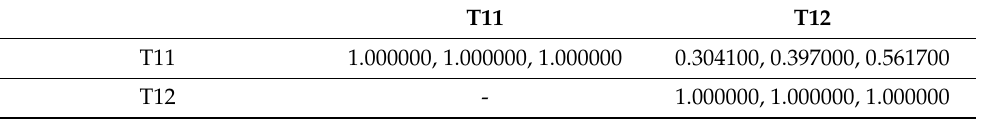
Table 2. Fuzzy aggregated pair-wise comparison matrix at level 2 for Compromise Level.